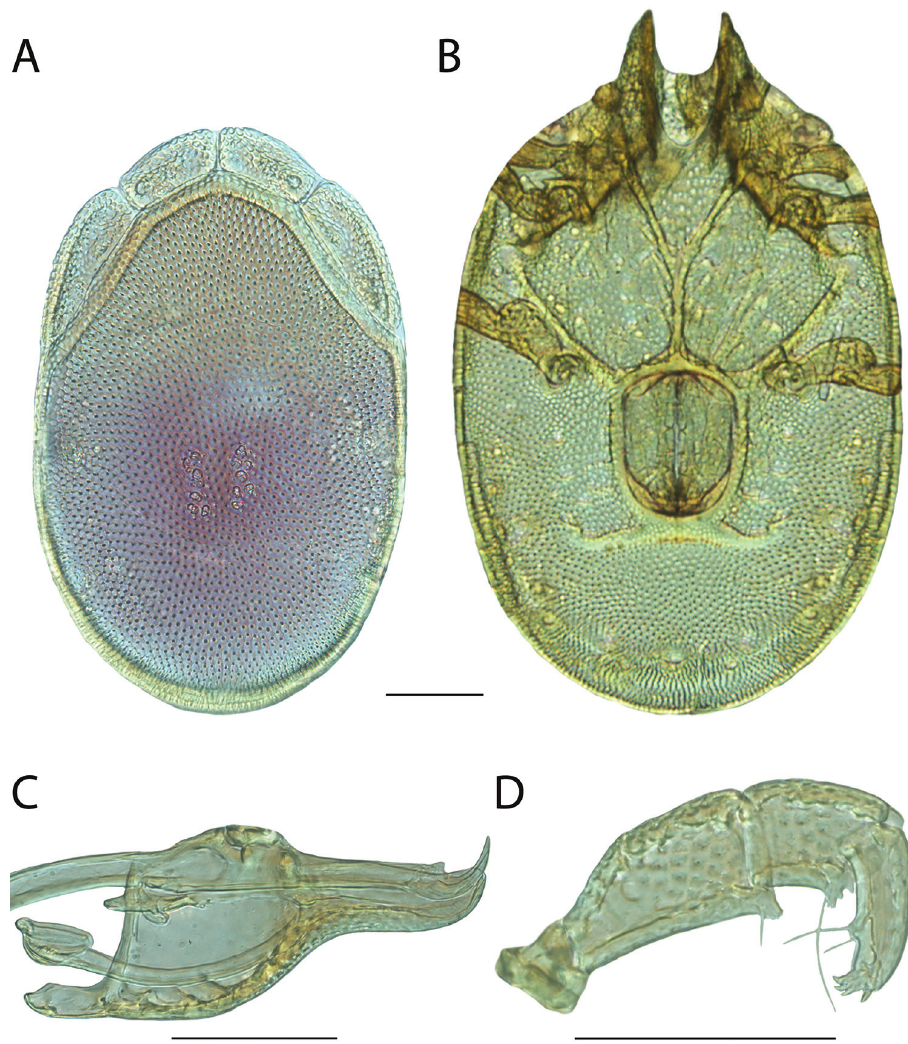
Figure 183. Torrenticola pacificensis sp. n. male: A dorsal plates B venter (legs removed) C subcapitulum D pedipalp (setae not accurately depicted). Scale = 100